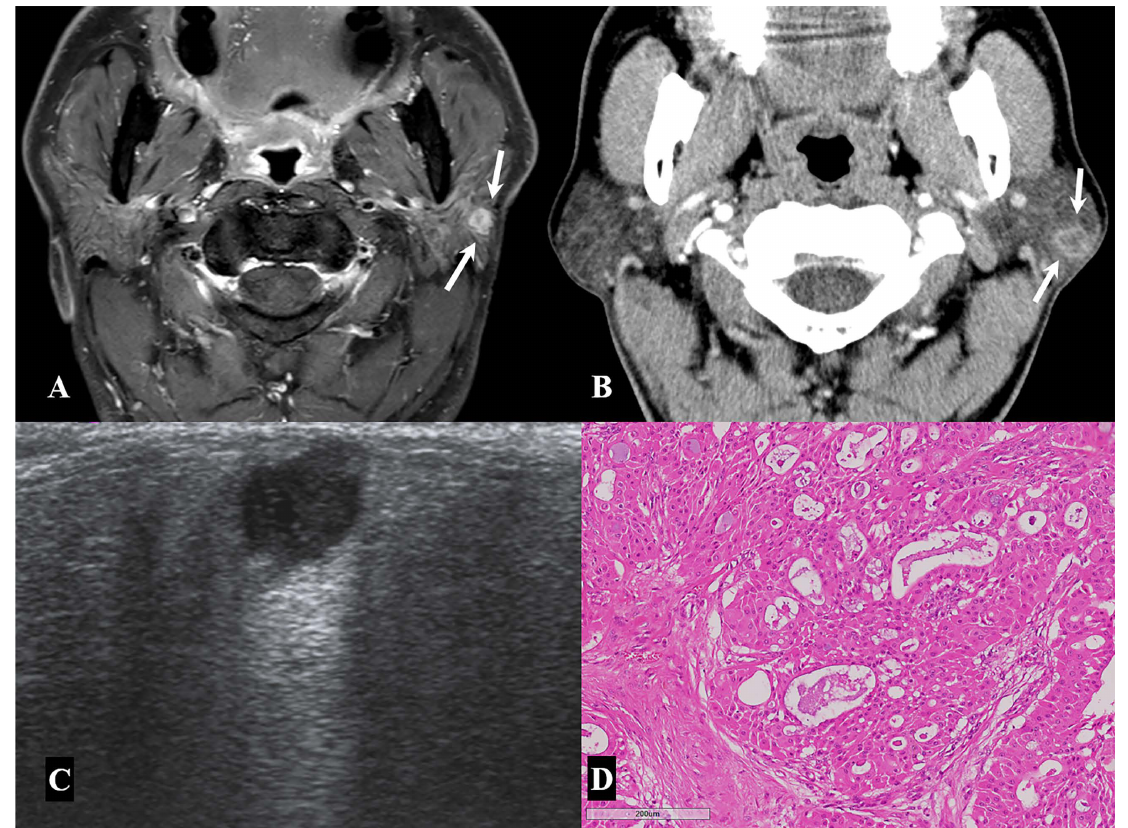
Figure 5. A 58-year-old man with low-grade mucoepidermoid carcinoma. ( A,B ) Contrast-enhanced axial T1-weighted image ( A ) and delayed enhanced axial neck CT image ( B ) show a small enhancing nodular lesion with a central non- enhancing portion in the left parotid gland. ( C ) On neck ultrasonography, there is a markedly hypoechoic nodule with a focal spiculated margin and posterior acoustic enhancement in the superficial lobe of the left parotid gland. ( D ) Histopathological examination of a specimen from the superficial parotidectomy shows sheets of mucous, squamous, and intermediate cells with bland-looking nuclei forming glandular spaces, suggestive of low-grade mucoepidermoid carcinoma ( × 100 magnification; hematoxylin and eosin